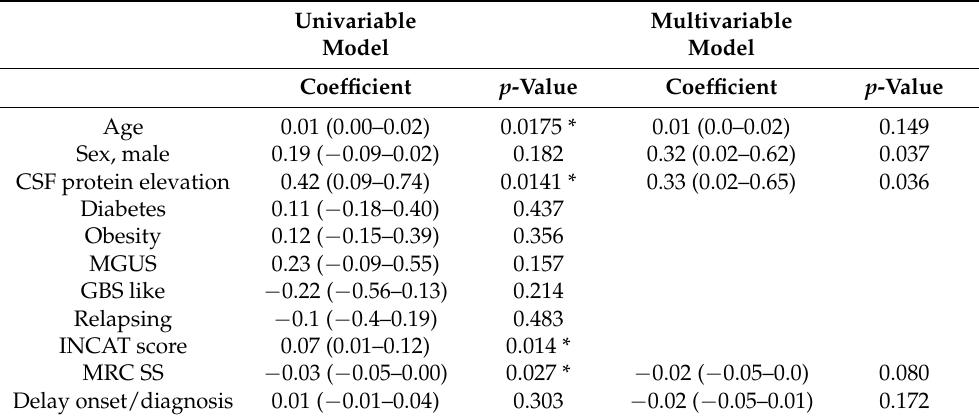
Table 2. Uni- and multivariabel model.